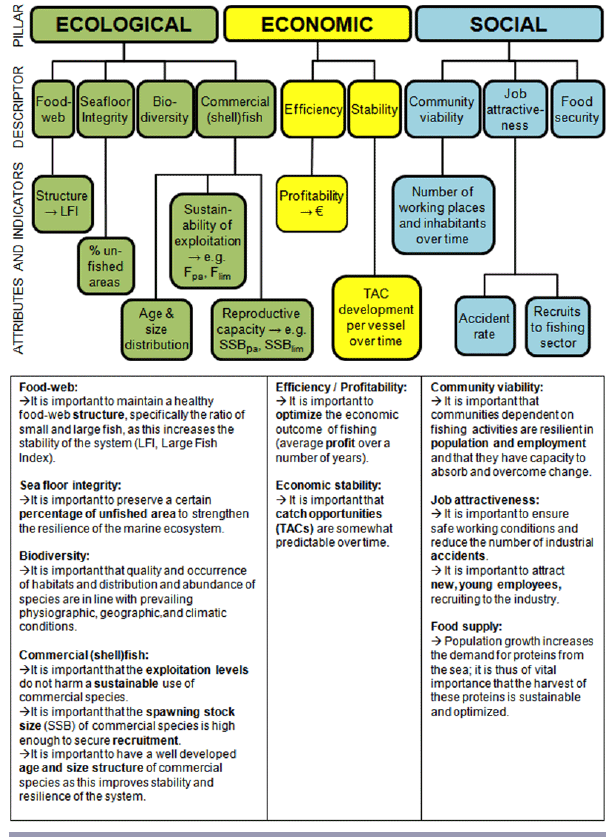
Fig. 1 . Systematic description of preferences concerning fisheries